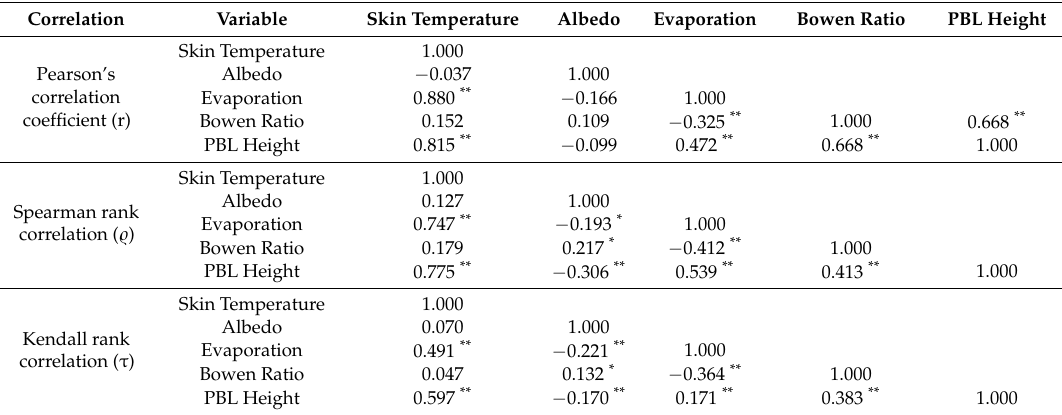
Table 5. Parametric (Pearson’s r) and non-parametric (Spearman’s (cid:36) and Kendall’s τ ) correlation for ERA-Interim derived variables in L2 transect. Number of samples =